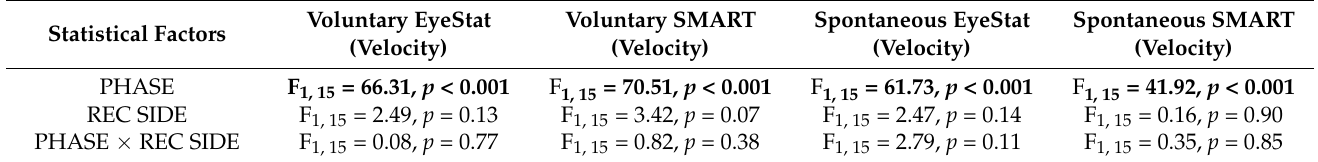
Table 4. Statistical analysis for the EyeStat device and SMART system recordings (voluntary and spontaneous blinking). The table shows the statistical output from the rmANOVA performed on the EyeStat device and SMART system on the voluntary and spontaneous blinking data. PHASE: blinking phase; REC SIDE: recording side. Significant factors and interactions are depicted in